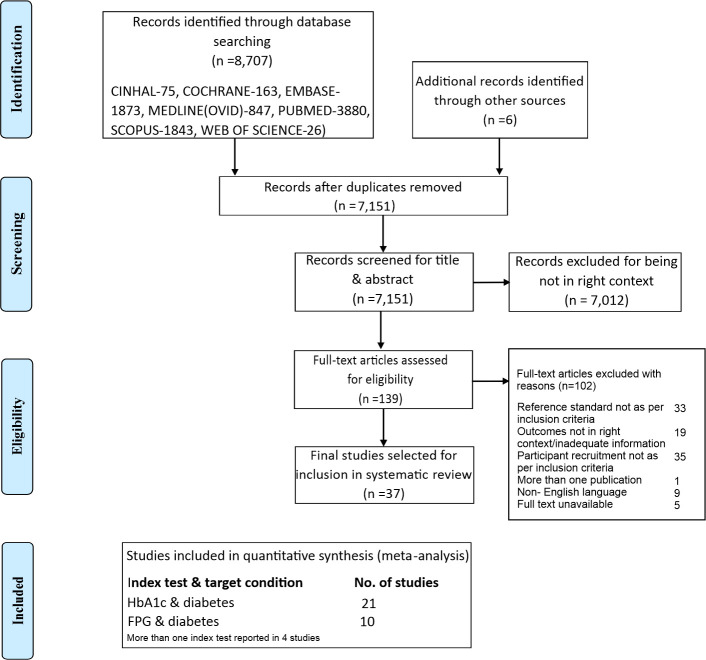
PRISMA flow diagram.